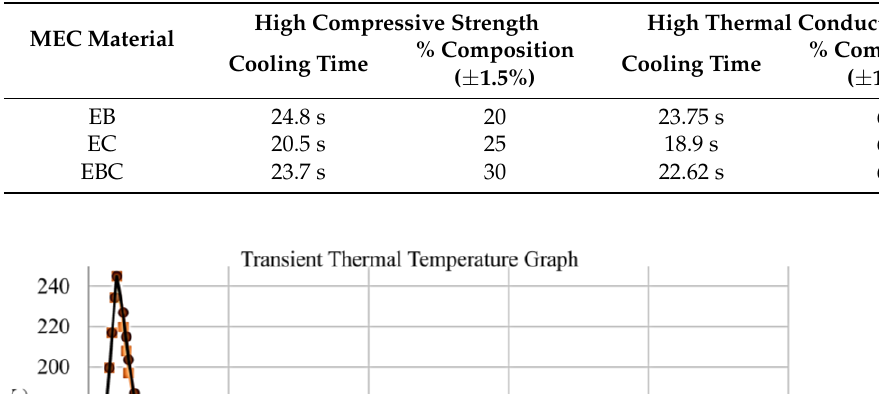
Table 12. Result of cooling time.